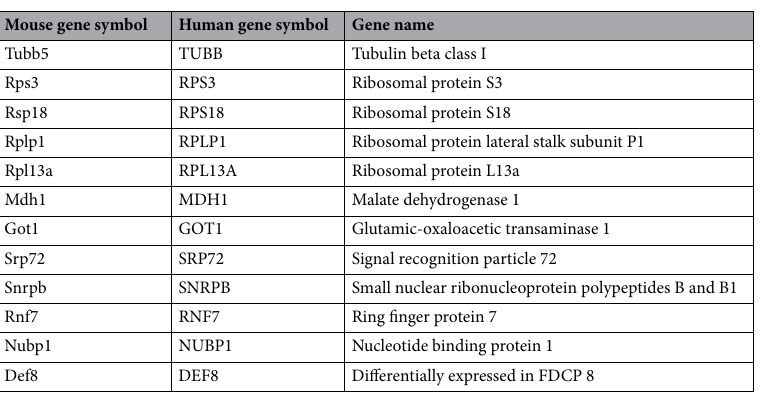
Table 2. Selected genes that do not change their expression more than three-fold during the iPS reprogramming.